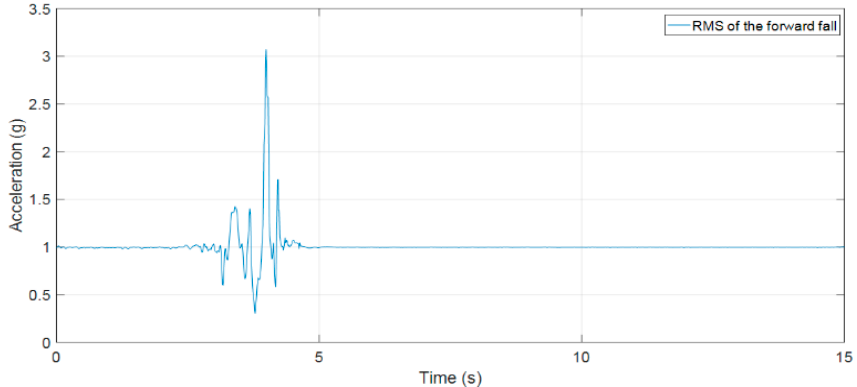
Figure 15. The RMS of acceleration of a fall forward from standing.